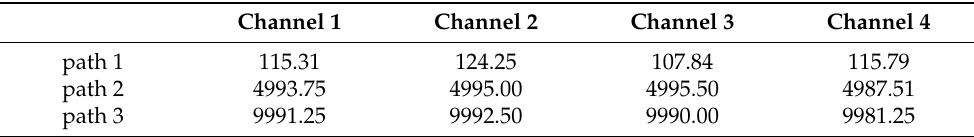
Table 2. Measured value of path delay (unit: ns).